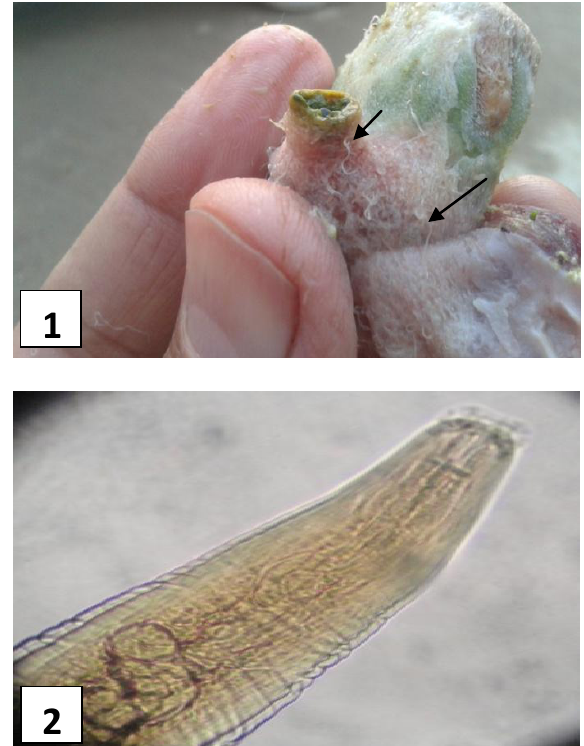
Figure, 1: Gross section reveals the presence of Hadjelia truncata parasite located under the koilin layer of the gizzard (x10). Figure, 2: Reveals the anterior end of the male and female of Hadjelia truncate parasite